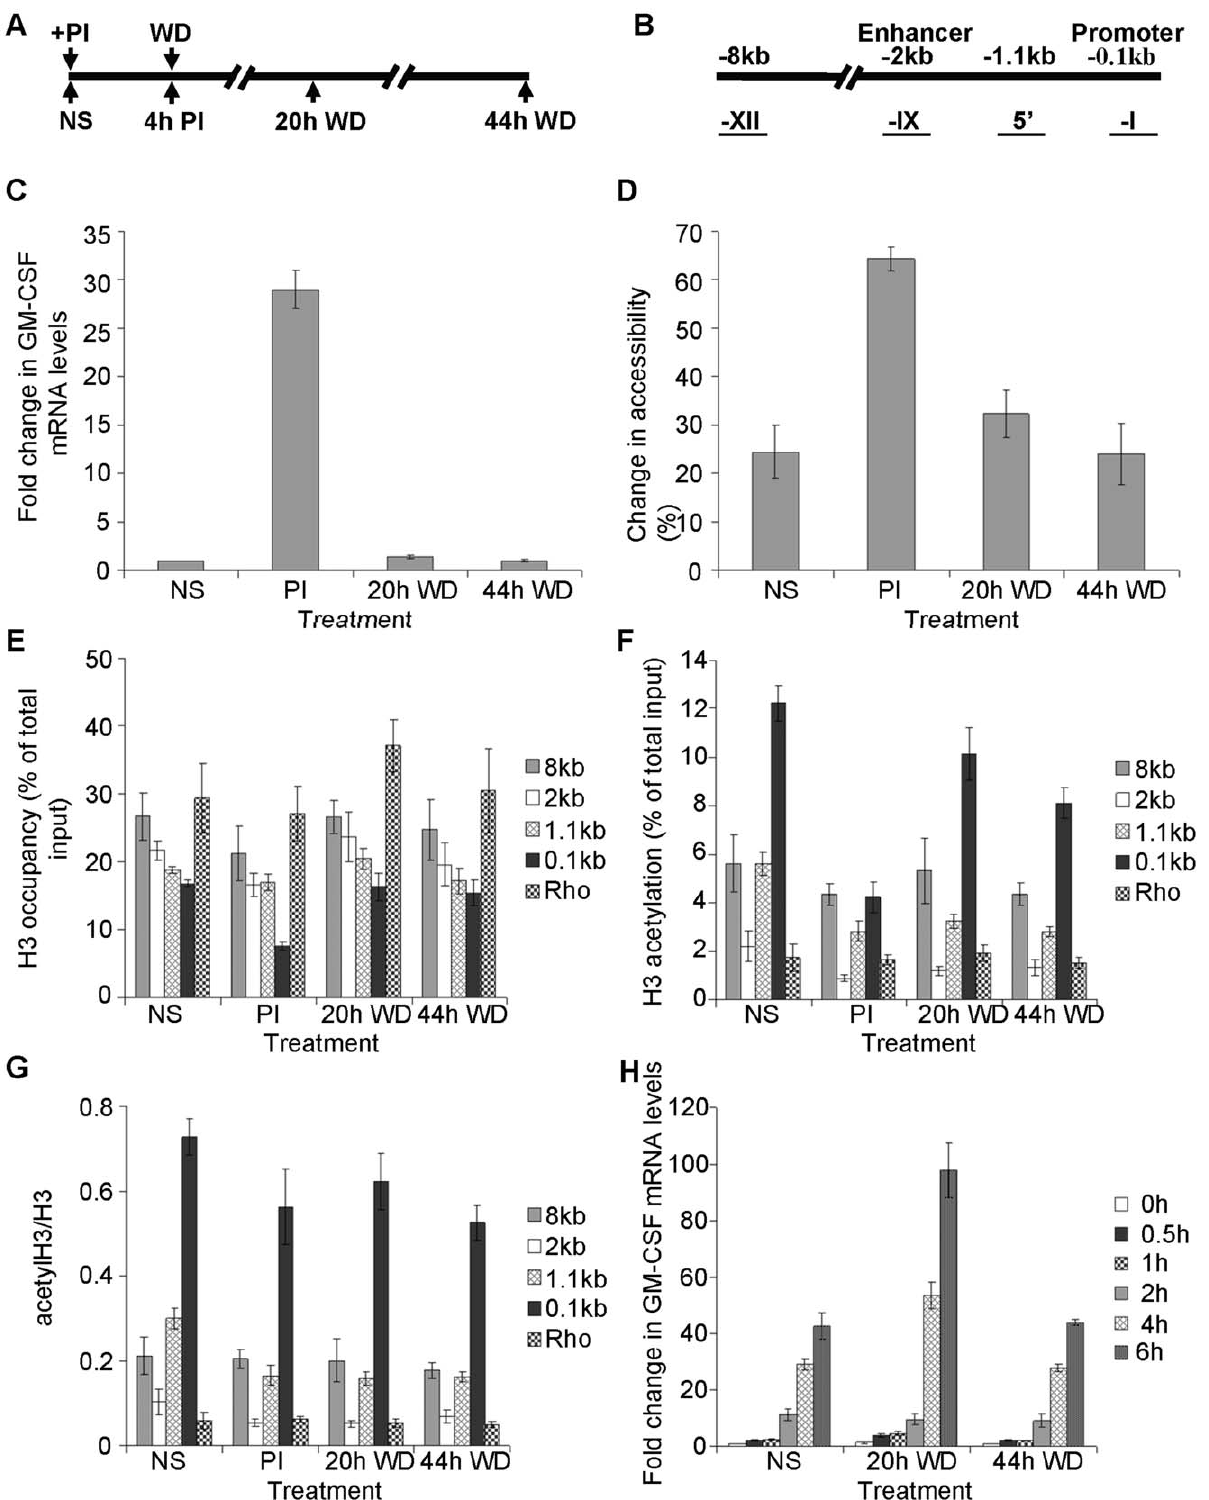
Figure 1. Histones are reassembled at the GM-CSF promoter following stimulus withdrawal. (A) Time course and sampling strategy used for the experiments. Samples were taken from unstimulated (NS) EL-4 T cells, from cells simulated for 4 h with PI (PI), and from cells 20 h and 44 h after withdrawal of the stimulus (20 h WD and 44 h WD). (B) Schematic depicting the position of GM-CSF primer sets used in PCR amplifications. (C– D) GM-CSF mRNA levels relative to GAPDH were determined by RT-qPCR (C) and promoter accessibility to MNase was determined by CHART-PCR (D), in EL-4 T cells treated as indicated. (E–F) Histone H3 (E) and acetylated H3 (F) levels were determined by ChIP analysis at the indicated genomic regions as shown in (B), in EL-4 T cells treated as indicated. (G) The ratio of acetylated H3 to total H3 as determined in (E) and (F) is depicted. (H) EL-4 T cells were either left unstimulated (NS) or treated for 4 h with PI, then the stimulus withdrawn for 20 h (20 h WD) and 44 h (44 h WD). GM-CSF mRNA